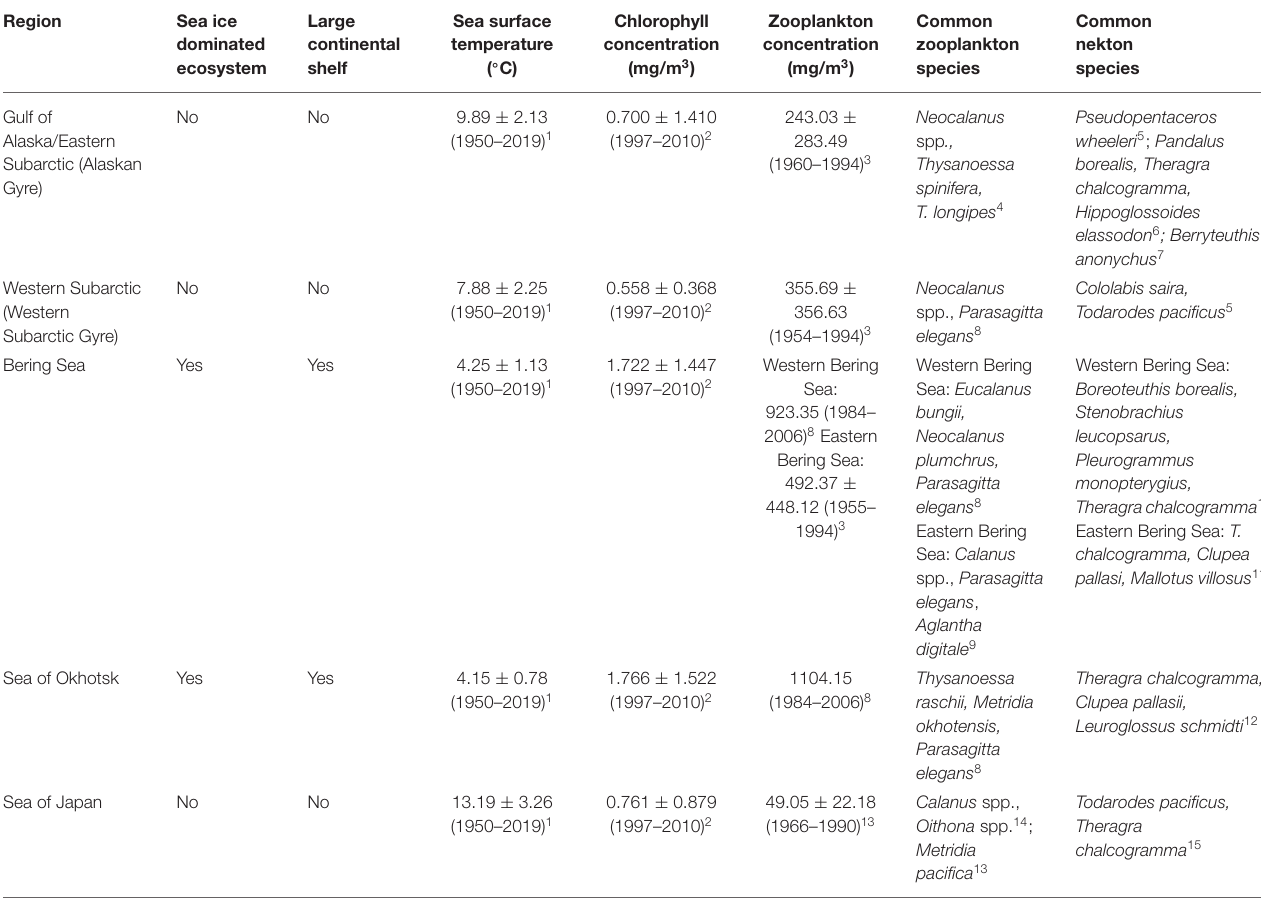
TABLE 1 | Oceanographic and biological information for each region of the North Pacific Ocean. Region Sea ice